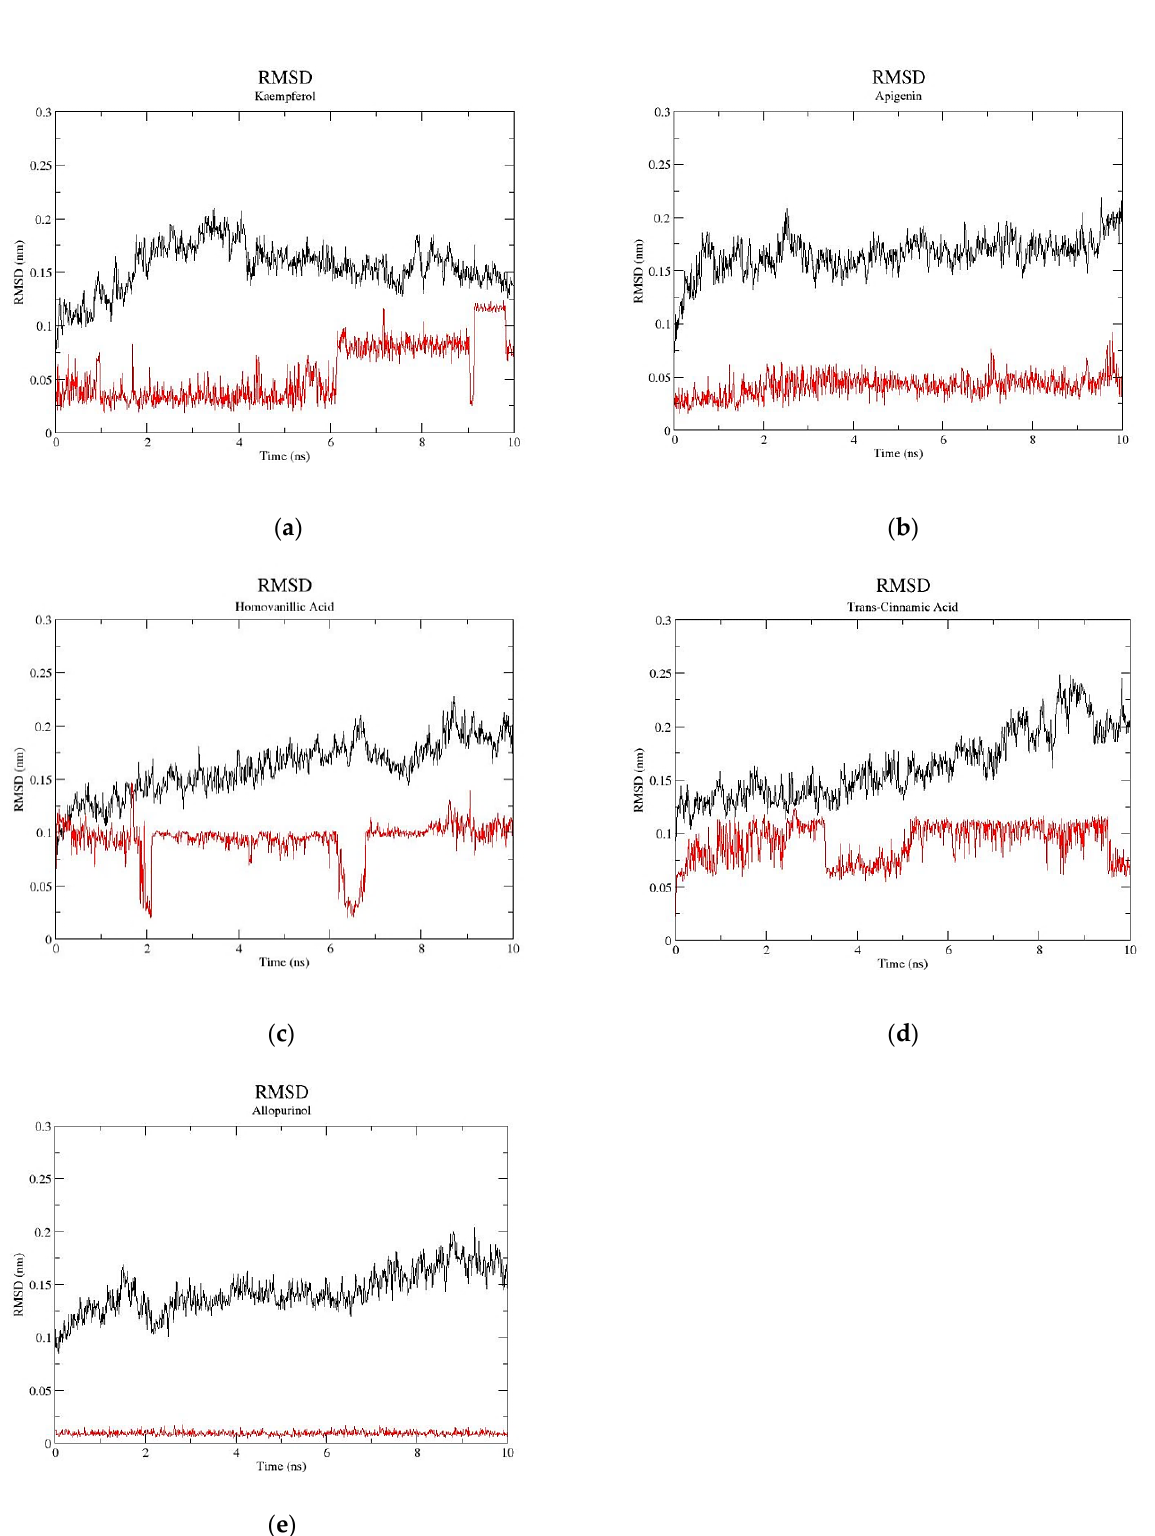
Figure 3. The monitoring of molecular dynamics trajectories. ( a ) kaempferol, ( b ) apigenin, ( c ) homovanillic acid, ( d ) trans -cinnamic acid, and ( e ) allopurinol. Black line: the backbone of protein; Red line: respective ligand.